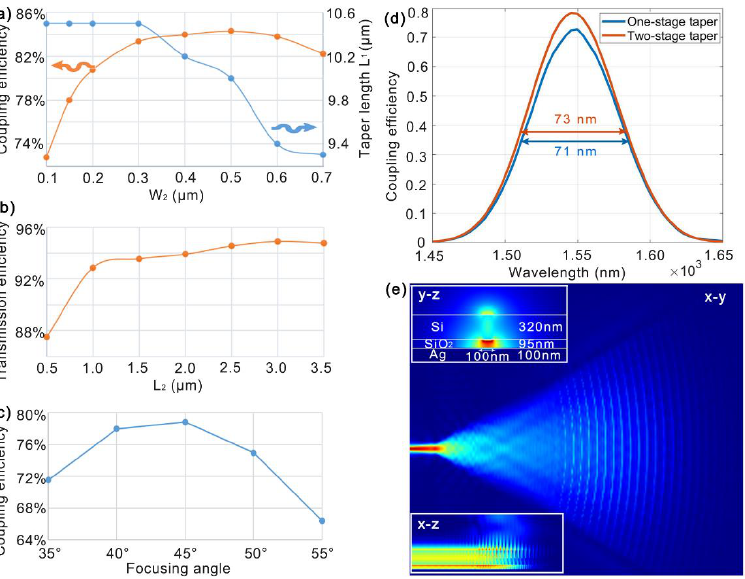
Figure 3. 3D FDTD simulation results of the apodized grating couplers for the silicon HPWs with a bottom metal layer. ( a ) CEs and optimal lengths of the taper for the couplers with the one-stage-taper. Here, W 1 = 7.5 µm and W 2 is tuned. ( b ) Transmission efficiencies of the second taper itself. Here, W 2 = 500 nm, W 3 = 100 nm, and the taper length L 2 is tuned. ( c ) Dependence of CEs on the focusing angle of the coupler. Here, L 2 = 3 µ m. ( d ) Transmission spectra for the couplers with the one-stage- taper or the two-stage-taper. Here, the focusing angle is 45 ◦ . ( e ) Light propagation (x-y plane) in the entire coupling structure with the two-stage-taper and a 100 nm-wide HPW. The upper and lower insets exhibit the mode profile in the waveguide (y-z plane) and light propagation in the x-z plane, respectively. The wavelength is 1550 nm for ( a – c , e